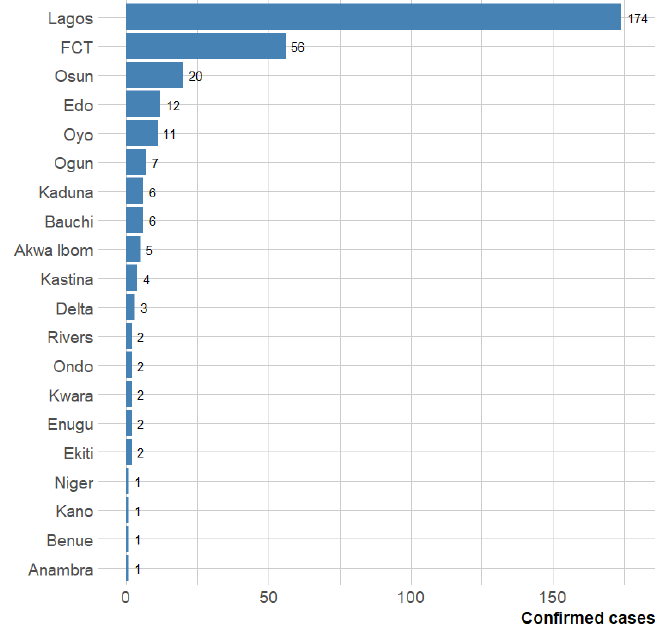
Figure A2. The number of confirmed cases per states in Nigeria.